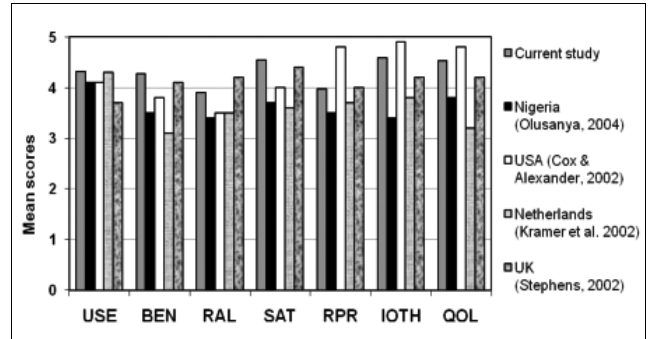
Fig. 3. Cross-country comparisons based on mean scores on IOI-HA items (1 = poorest outcome; 5 = best outcome) (USE = daily use; BEN = benefit; RAL = re- sidual activity limitations; SAT = satisfaction; RPR = residual participation restric- tion; IOTH = impact on others; QOL = quality of